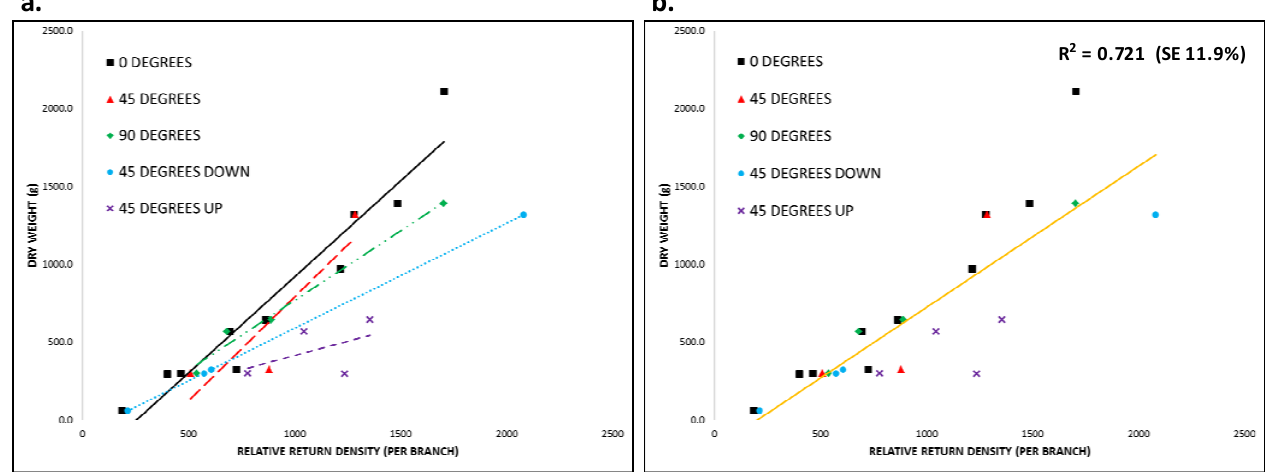
Figure 14. Angular effects on Douglas-fir branch biomass models. (a) Relative return density per branch vs. dry weight in grams for each of five branch sample angles: 0° ( r 2 = 0.923; SE 26.7%), 45° ( r 2 = 0.788; SE 92.2%), 90° ( r 2 = 0.983; SE 42.6%), 45° up ( r 2 = 0.262; SE 14.1%), and 45° down ( r 2 = 1.00; SE 55.7%). (b) Relative return density per branch vs. dry weight in grams for all angled scans ( r 2 = 0.721; SE 11.9%). Removing the problematic 45° up scans changes the regression and SE slightly ( r 2 = 0.834; SE 14.6%). a. b.